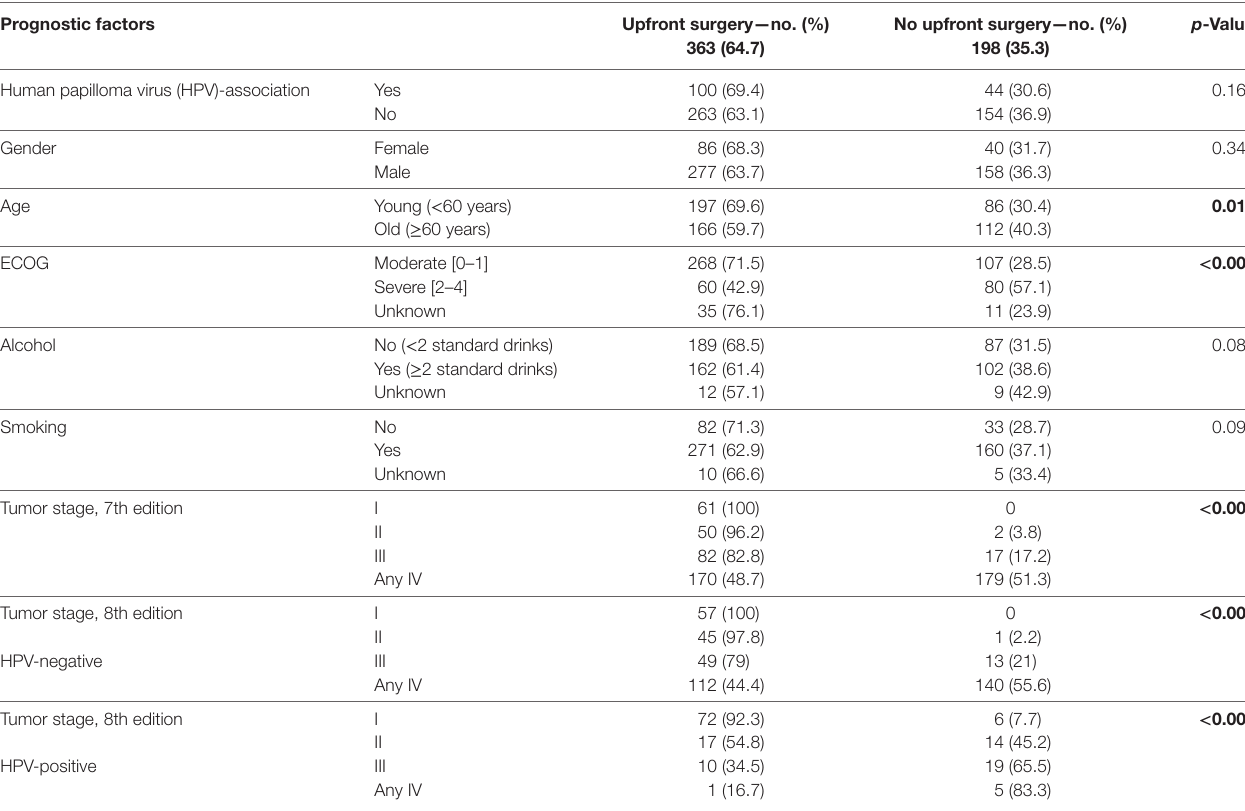
taBLe 2 | Prognostic factors in 561 consecutive patients with oropharyngeal cancer before curative therapy. prognostic